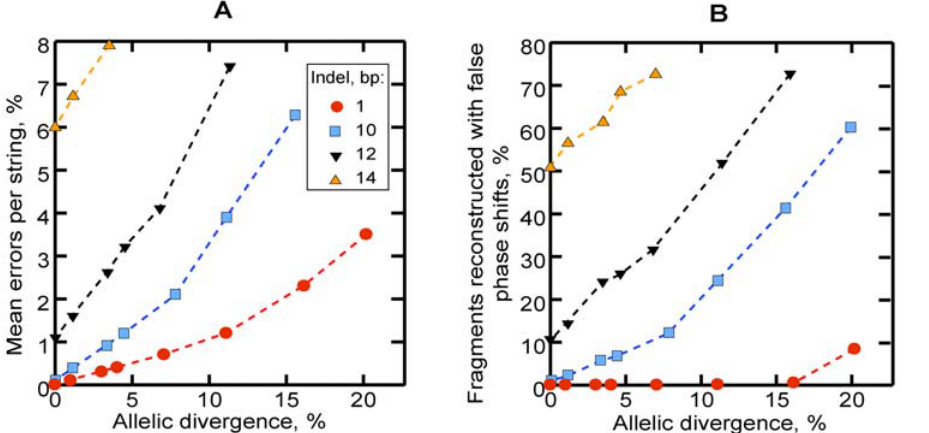
Figure 8. Accuracy of decoding of simulated 100 bp mixed fragments containing a single insertion of variable size in the middle. (A) Mean percent of erroneous bases per reconstructed string. (B) Percent of fragments reconstructed with incorrect indels. Each point represents 1,000 runs. For SD and additional statistics, see Table S2.